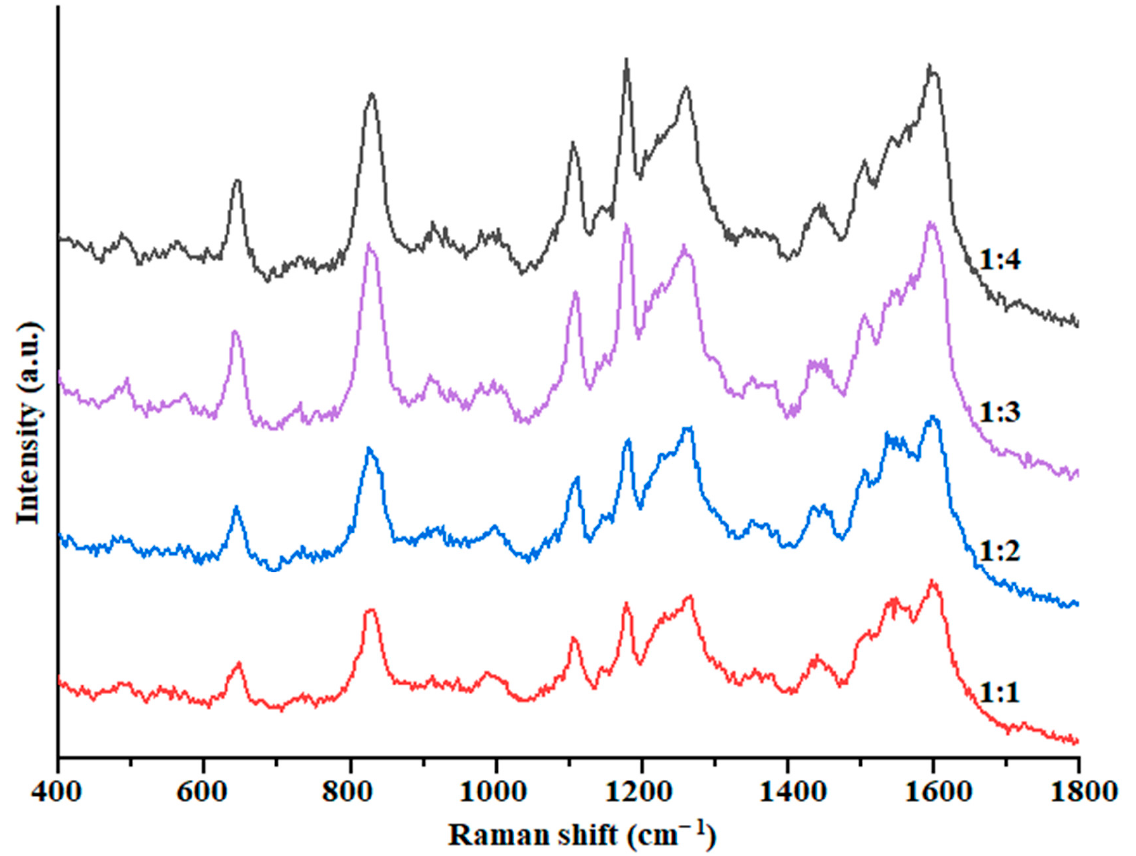
Figure 5. Effect of the solution—substrate ratio on the SERS spectrum of BPA in methanol solution.